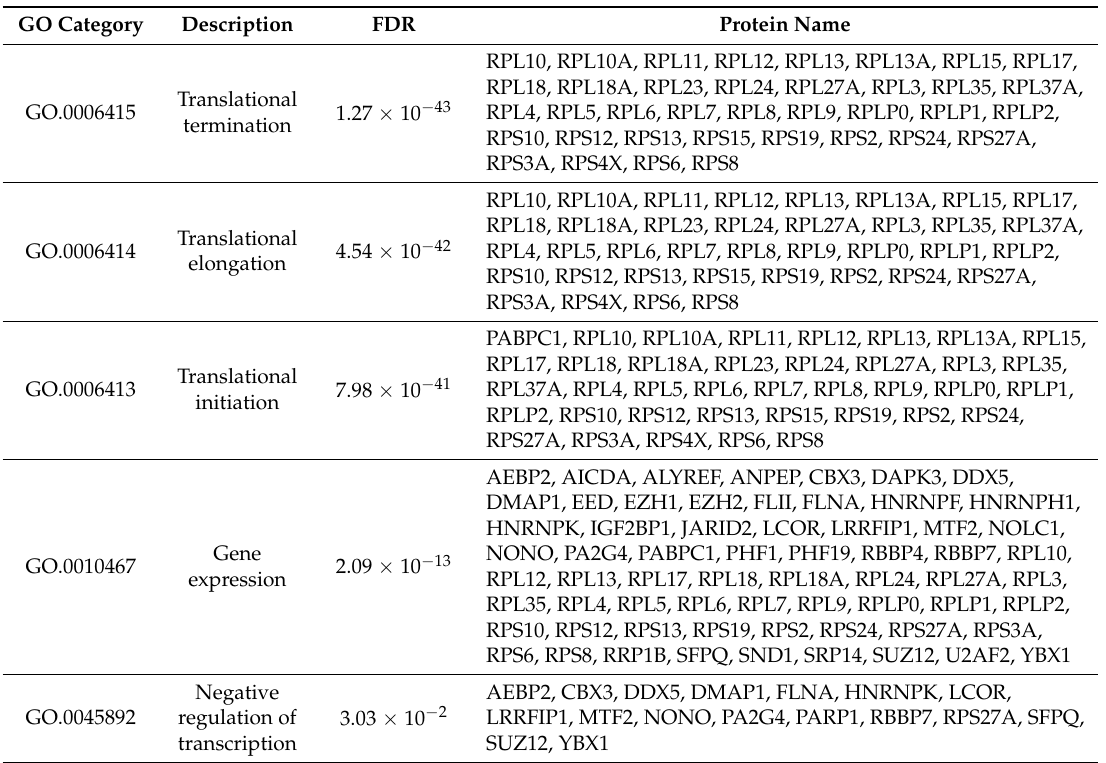
Table 1. STRING gene